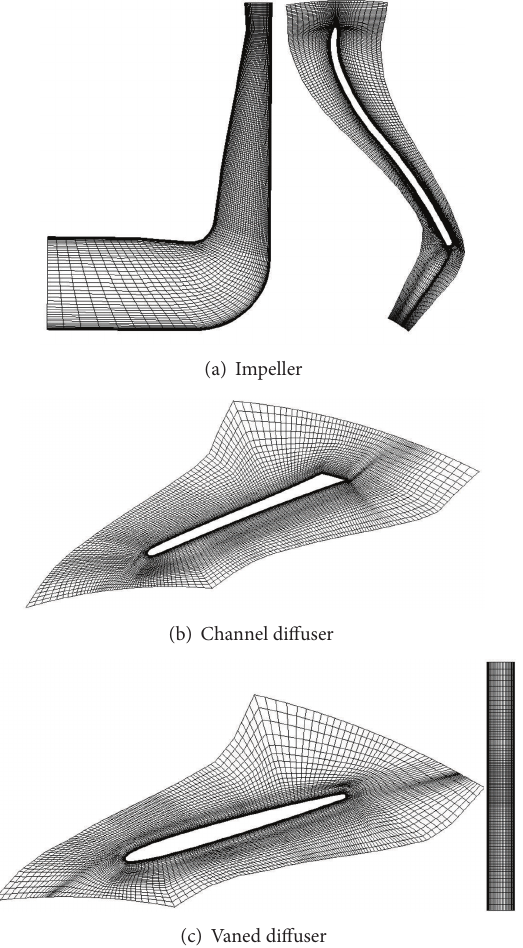
Figure 6: Grids of the stage elements.